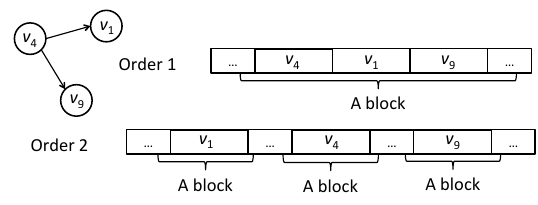
Fig. 7 Two different layouts of a